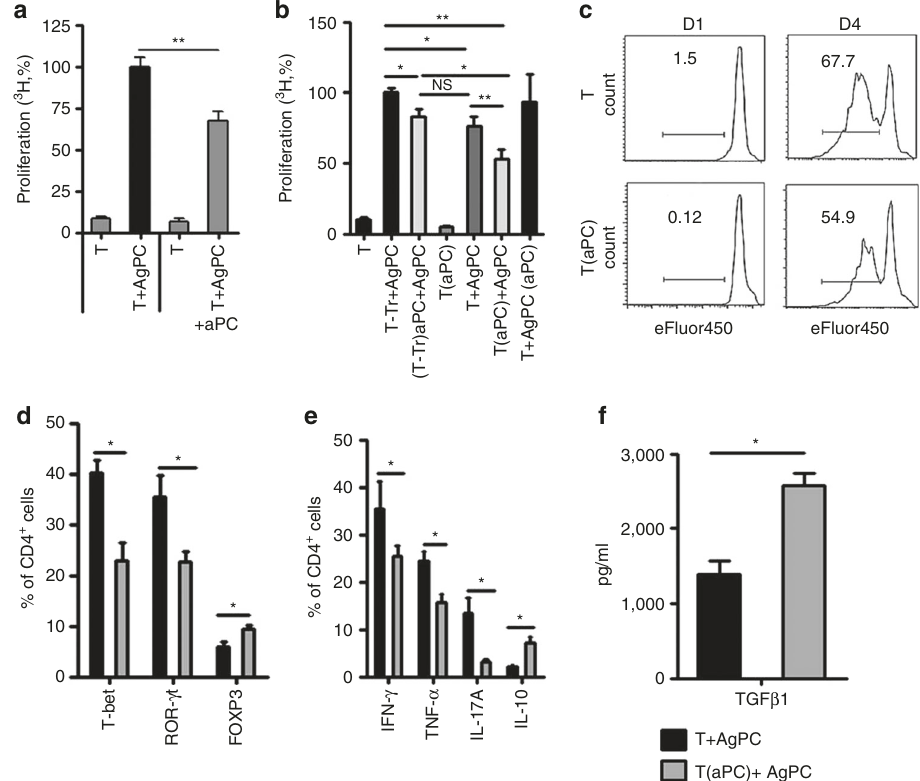
Fig. 4 aPC promotes T reg expansion and inhibits T-cell reactivity in human T-cells. a Mixed lymphocyte reaction ( MLR ) of human peripheral blood T-cells (T) with allogenic antigen-presenting cells ( AgPC ) for 96 h. T-cell reactivity was measured by thymidine incorporation during the fi nal 16 h. Concomitant incubation with aPC (+aPC; 20 nM, every 12 h) reduces T-cell reactivity. b aPC-preincubation (20 nM, 1 h, 37 °C) of human pan T-cells (T(aPC) + AgPC), but not of human AgPC (T + AgPC(aPC)) reduces T-cell reactivity in the MLR in comparison to T reg -depleted T-cells (T-Tr + AgPC) and T-cells (T + AgPC). c Human pan T-cells without (T) or with (T(aPC)) aPC-preincubation were labelled with eFluor450, stimulated with AgPC, and proliferation was measured on day 1 ( D1 ) and day 4 ( D4 ) by FACS. d , e aPC-preincubation of human pan T-cells reduces the frequency of CD4 + T-bet + and CD4 + ROR- γ t + T-cells while increasing CD4 + FOXP3 + T regs ( d ). Concomitantly, expression of the pro-in fl ammatory cytokines IFN- γ , TNF- α , and IL-17A, as measured by fl ow cytometry after 48 h of MLR, is reduced, while that of IL-10 is increased ( e ). f TGF β 1 levels in the supernatant of human T-cells MLR, measured after 96 h by ELISA. Results of at least three independent experiments ( a , b , and d – f ), each containing cells from three different donors, are shown; representative histogram plots c from triplicate wells of three independent experiments are shown; MFI and exemplary FACS images corresponding to Figs. 4d, e are shown in Supplementary Figs. 6 and 7; * P < 0.05, ** P < 0.01 ( a , d – f : t -test, b